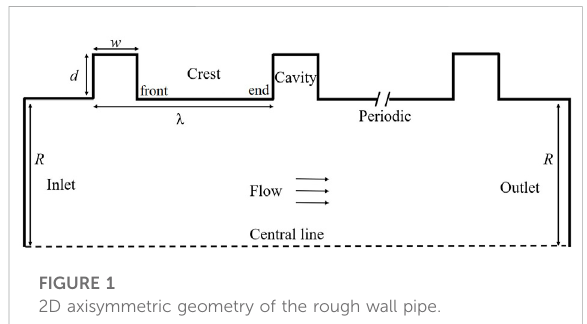
FIGURE 1 2D axisymmetric geometry of the rough wall